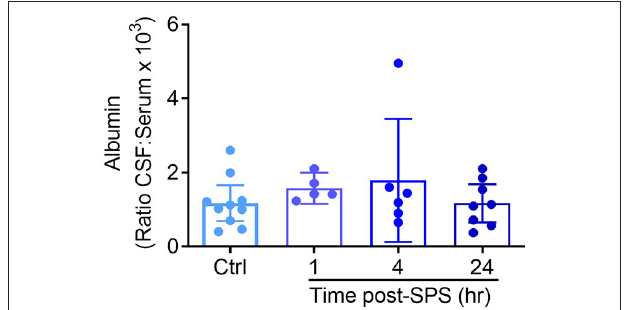
FIGURE 6 | No evidence that SPS disrupts blood brain barrier permeability between 1 and 24h post-SPS. The ratio of albumin in the CSF and serum from rats euthanized at each time point post-SPS was determined by ELISA and is presented as a scatter plot with mean ± 95% CI. No differences in the CSF to serum albumin ratio were found between groups ( p = 0.3571) by Kruskal-Wallis test.